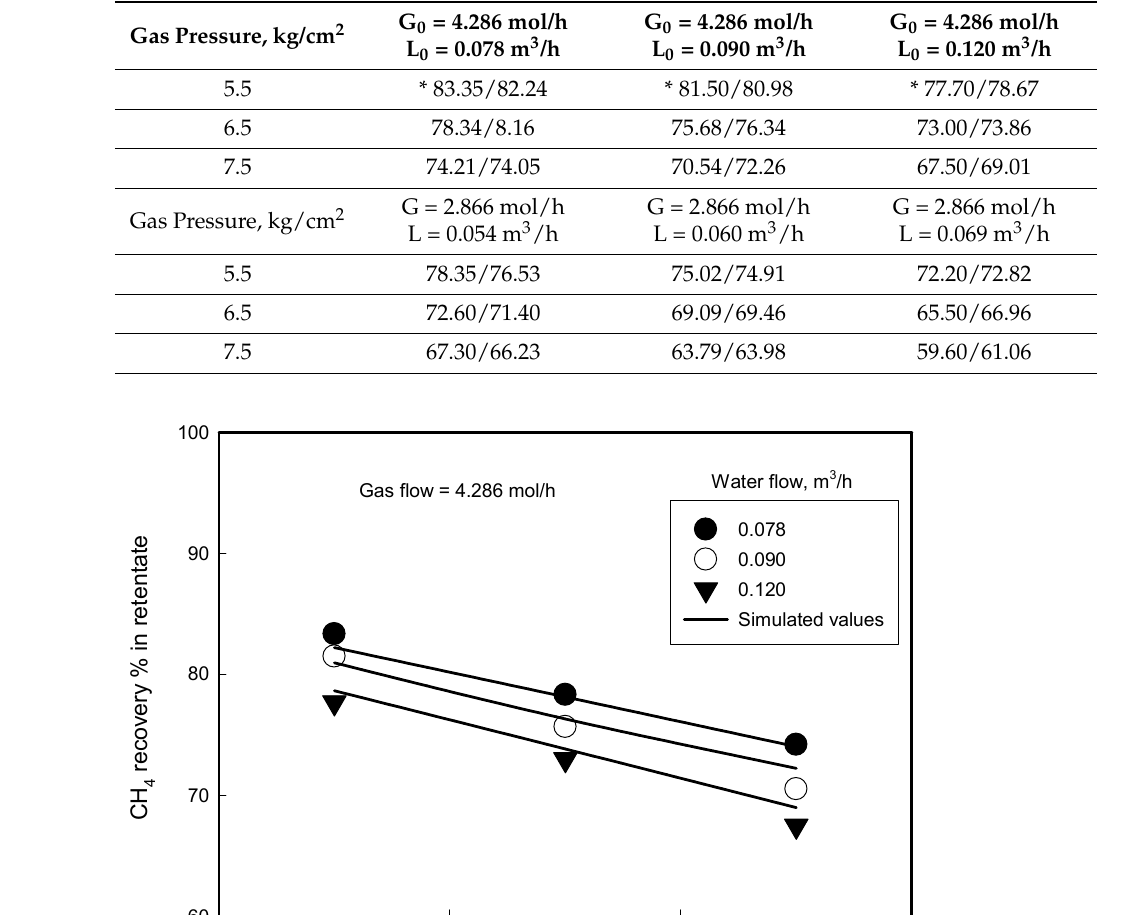
Table 3. Comparison of calculated CH 4 recovery percent to real values through porous polypropylene hollow fiber membrane with OD/ID = 1000/700 mm, number of HF = 700, Effective membrane length = 29 cm, determined R value = 0.155, *( )/( ): *experimental value/simulated value.